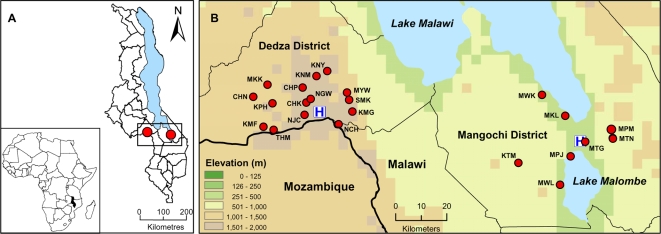
Location of study areas in Dedza and Mangochi districts.(A) relative to the national and district administrative boundaries of Malawi and (B) showing enlargement of study region with position of villages (see Table 3 for 3-letter codes) and district hospitals (marked H).